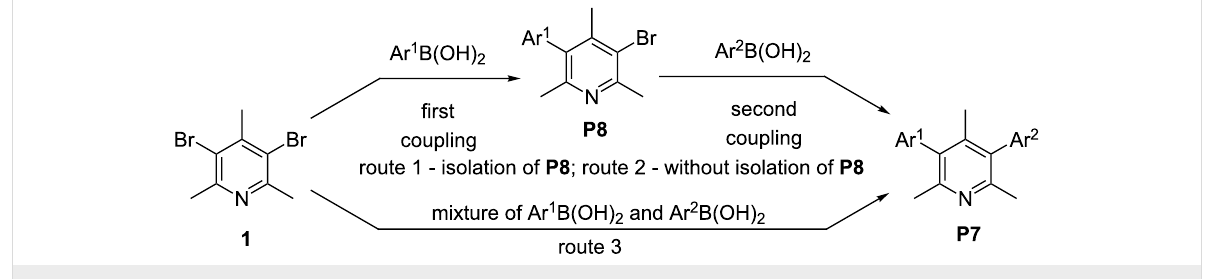
Scheme 2: Synthetic routes leading to unsymmetrically substituted arylpyridines.